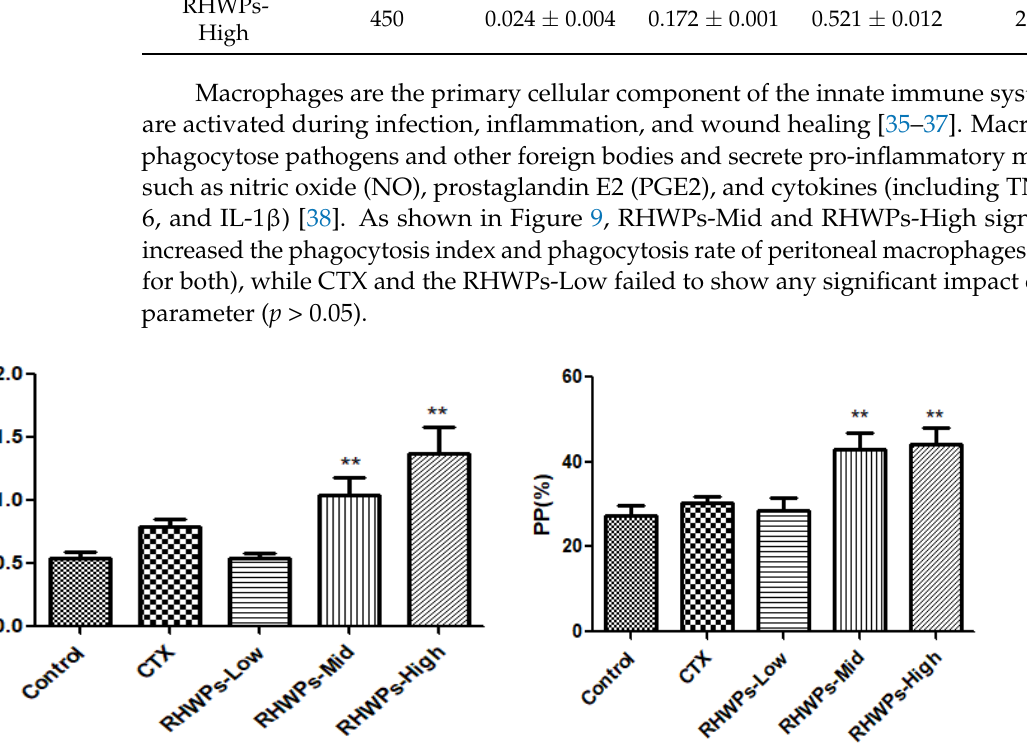
Figure 10. Effect of RHWPs on NO content in serum of S180 tumor-bearing mice. The concentra- tion of NO in serum of S180 tumor-bearing mice was determined by ELISA kit. Data are means ± SD ( n = 10). Significant differences from the control groups are designated as ** p < 0.01. 3. Experimental Section 3.1. Chemicals and Reagents RHWs were purchased from the Sichuan Chengdu Medicinal Materials Market in China. S180 cells and YAC-1 cells were provided by Shanghai Zhong Qiao Xin Zhou Bio- technology Co. Ltd. (Shanghai, China). RPMI-1640 was purchased from GE Medical Life Sciences (Harrogate, UK), streptomycin and TritonX-100 from Solarbio Co. Ltd. (Beijing, China), and fetal bovine serum (FBS) from Zhejiang Tianhang Biotechnology Co. Ltd. (Hangzhou, China). Dimethyl sulfoxide (DMSO), murine TNF-α, IFN-γ and IL-2 detec- tion kits, concanavalin-A (ConA), and lipopolysaccharides (LPS) were purchased from Beijing Boao Tuoda Technology Co, Ltd. (Beijing, China). Switzerland-Giemsa compound dyeing liquid was obtained from Nanchang Yulu Experimental Equipment Co. Ltd. (Nan- chang, China) Red blood cell lysis buffer was purchased from Tiangen Biochemical Tech- nology (Beijing, China) Co. Ltd. (Beijing, China). All other reagents were of analytical grade.